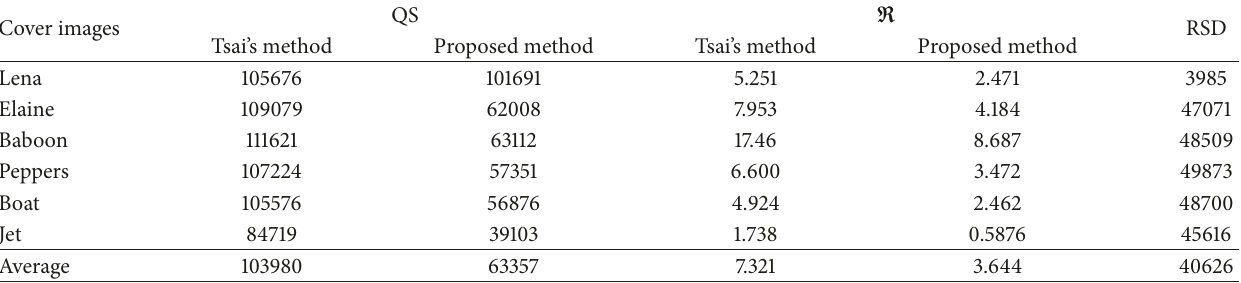
Table 2: The reduced effect of shifting distortion of asymmetric error histogram.